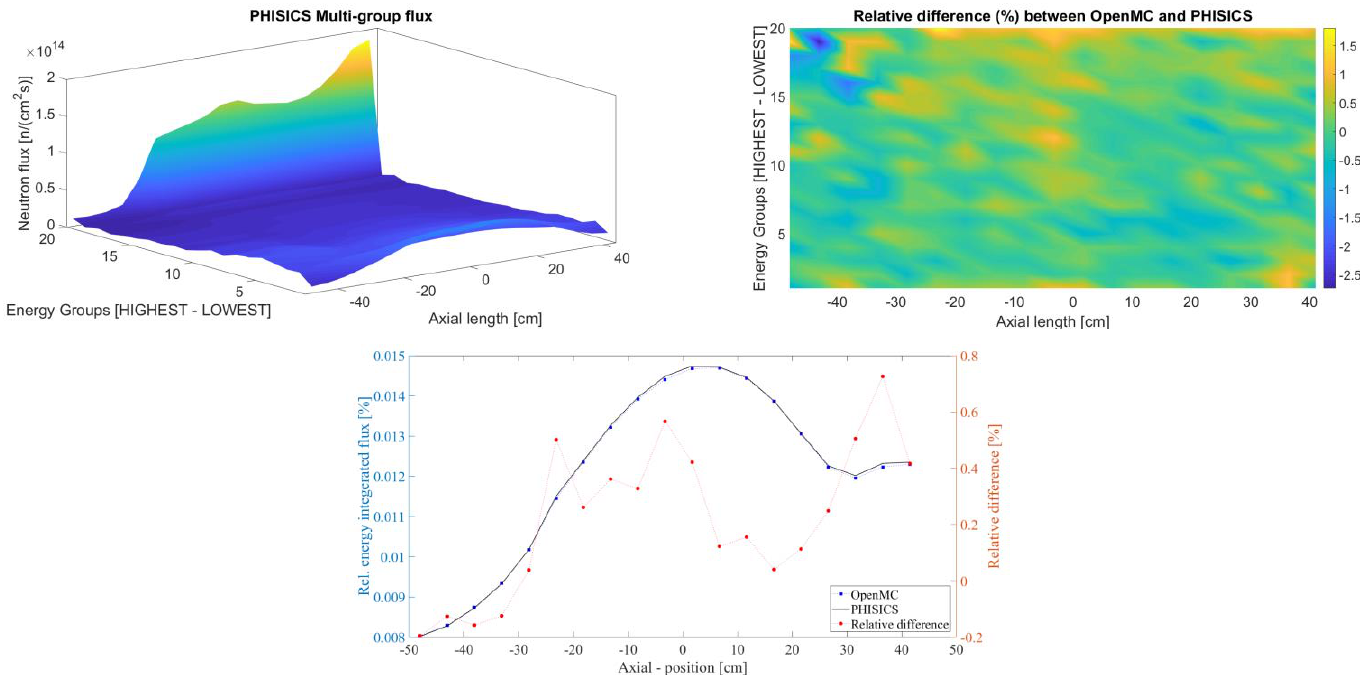
Figure 8. PHISICS vs. OpenMC MGMC benchmark at thermal